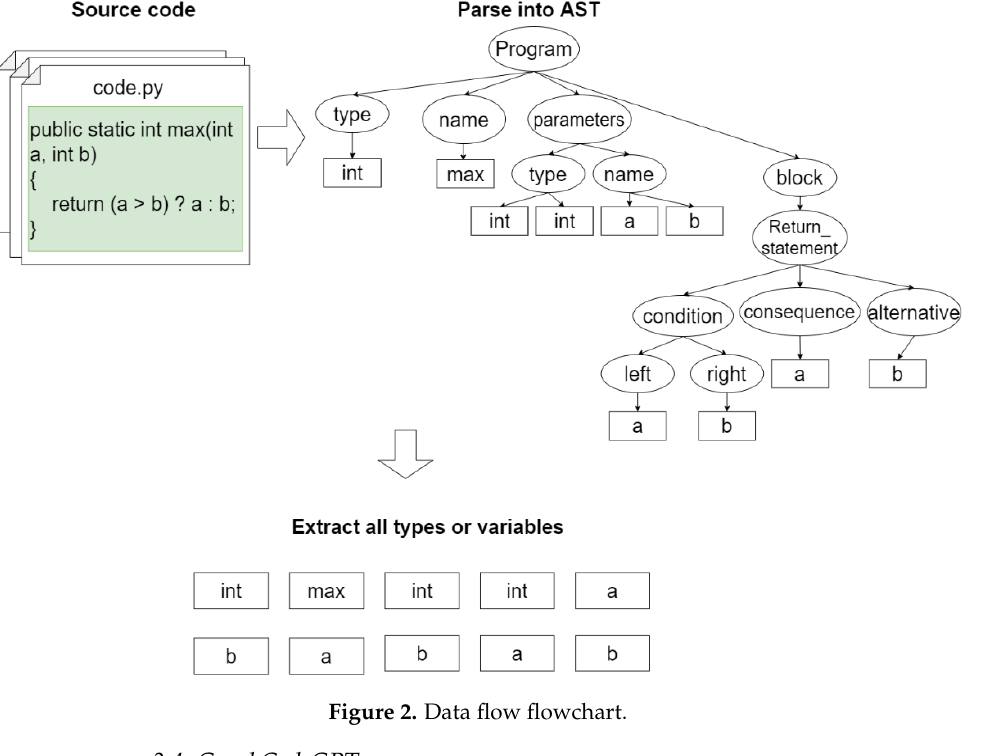
Figure 2. Data flow